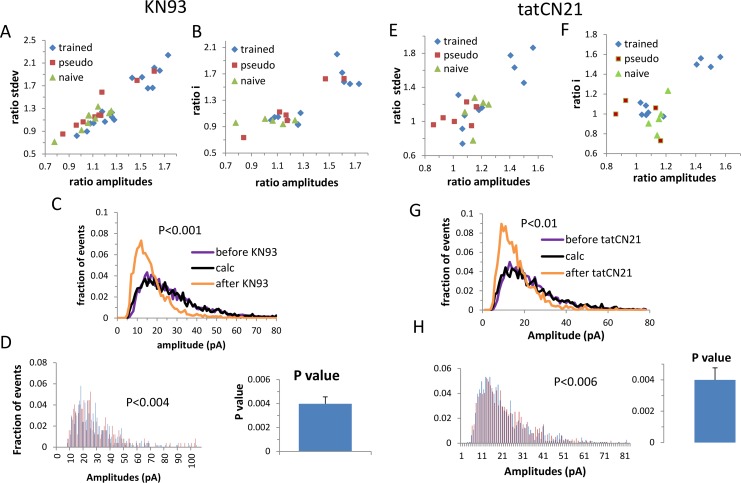
CaMKII blockers (KN93 left; tatCN21 right) act through a whole-cell, two-fold division of the GABAA single channel conductance in a subset of cells from trained rats.A, E: Depicted for each cell is the effect of CaMKII blocker on the average and standard deviation of the event amplitudes. The effect of the CaMKII blocker clearly exhibits two clusters, where one cluster exhibits a large blocker effect on the average and standard deviation of the event amplitude (KN93: trained, n = 16; pseudo, n = 8; naïve, n = 10. tatCN21: trained, n = 10; pseudo, n = 7; naive, n = 5) B, F: Similarly, the effect of CaMKII blocker on the average event amplitude and single channel current exhibits two clusters (KN93: trained, n = 12; pseudo, n = 6; naive, n = 5. tatCN21: trained, n = 10; pseudo, n = 4; naïve, n = 5). C, G: An amplitude distribution curve averaged for all cells in the affected cluster (all cells in the blocker affected cluster for which the single channel current could be calculated; KN93: n = 5; tatCN21: n = 4) is shown for the event amplitudes recorded before (purple) and after (orange) CaMKII blocker. The blocker effect was computationally reversed (black curve) by applying the reverse calculation on the data recorded after applying the CaMKII blocker: The fraction of events that were affected by the drug was calculated (Materials and Methods). This fraction of events was randomly selected from the events recorded after the blocker was applied and the amplitude of these events was multiplied by a factor of two. A new amplitude distribution curve was calculated from the whole set of data, using both the multiplied and the non-multiplied events, exhibiting a fully computationally reversed CaMKII blocker effect. The P values were calculated using Cramer Von Mises two-sample test. D, H: the blocker effect could be reversed in each cell separately. Left: an example of one cell where the histogram of events amplitudes before CaMKII blocker (blue) matched the histogram of the calculated events amplitude after the blocker effect was computationally reversed (red), right the P value was calculated for each cell and the average of these P values was calculated from all cells in the highly affected cluster.